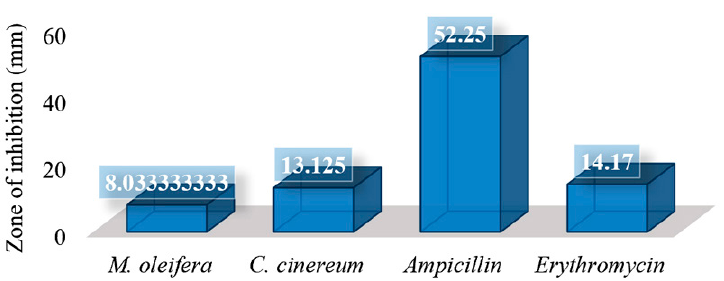
Fig. 7. Difference in zone of inhibition for natural and synthetic antibiotics against S. Table 9. Results obtained from the ANOVA analysis for methanol and hexane extracts for M. oleifera at 100%, 75%, 50%, 25%, 10% and 5% concentration against P. aeruginosa ANOVA Source of